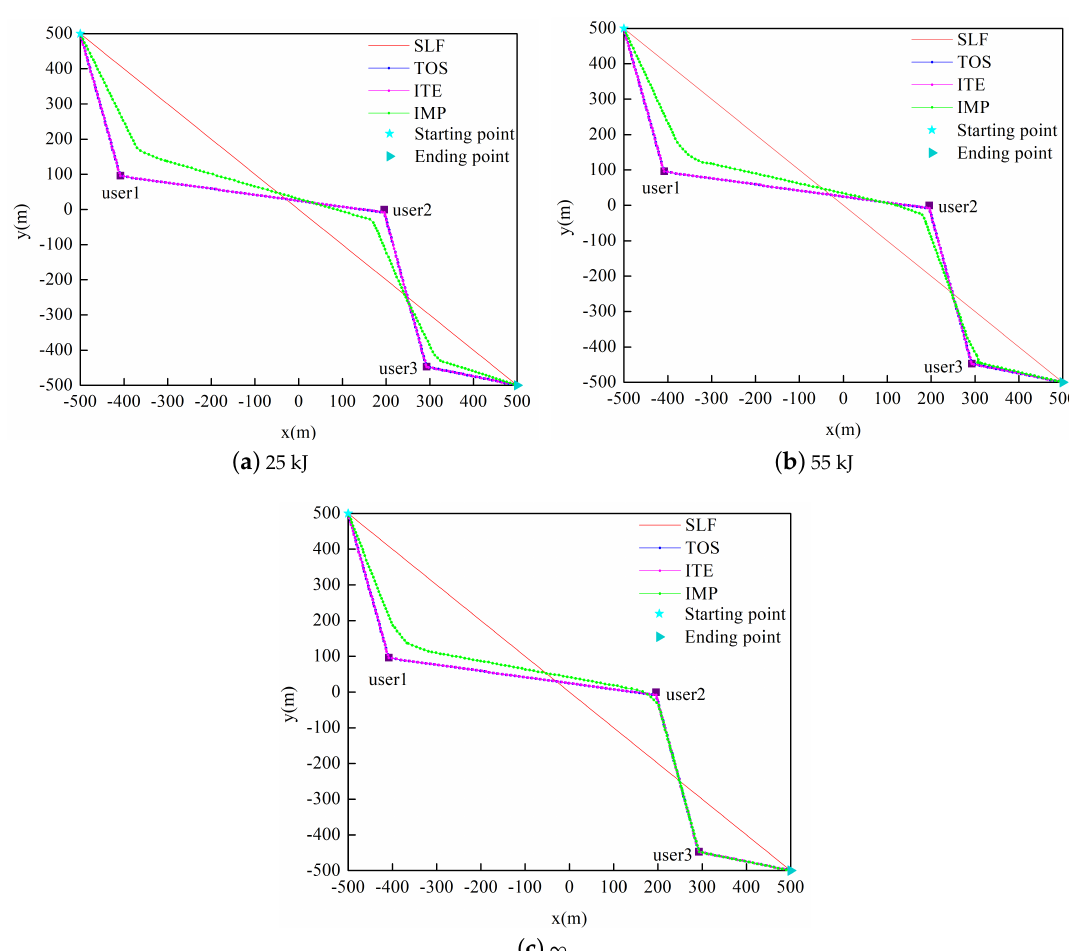
Figure 5. According to different data requirements, the speed comparison of UAV.